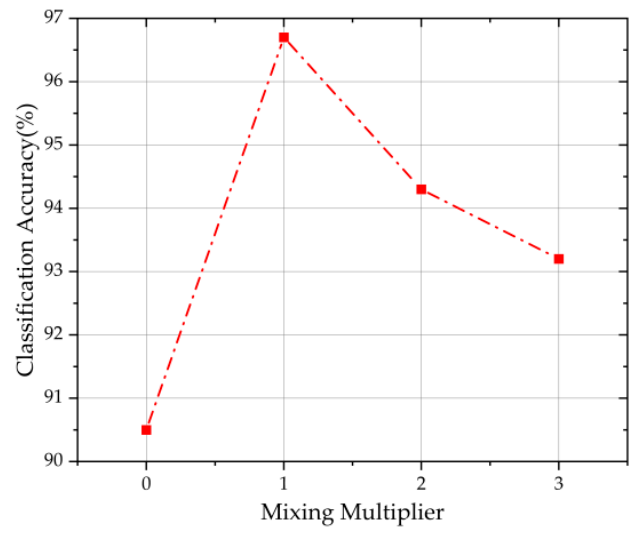
Figure 13. C lassification accuracy of the dataset with different mixing multipliers. Figure 13. Classification accuracy of the dataset with different mixing